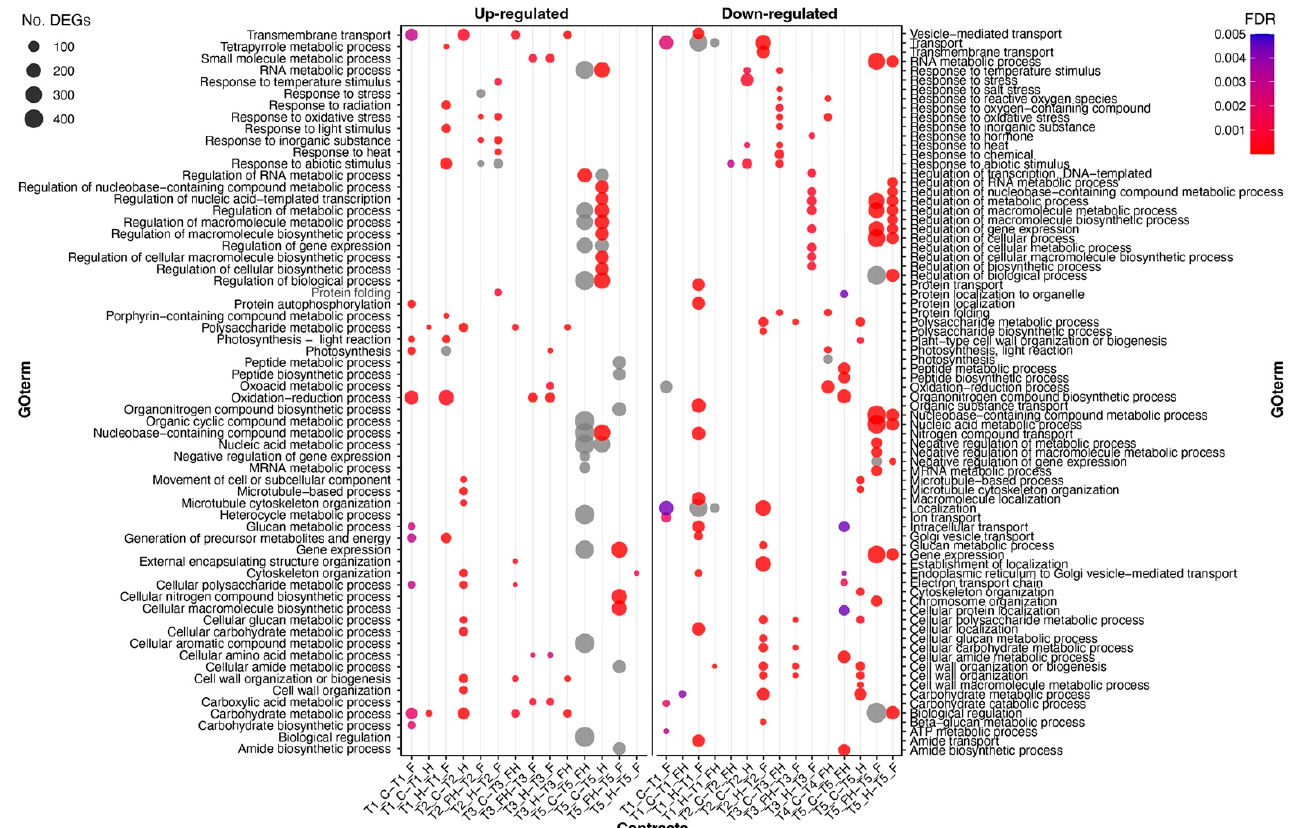
Figure 6. Dot plot of the enriched GO terms in the different contrasts. For each GO term enriched in either up ‐ regulated ( left ) or down ‐ regulated genes ( right ), the number of DEGs annotated, and the FDR statistics are represented as shown in the legends at the top left and right, respectively. Samples within each contrast are named according to the timepoint and treatment (C, control; F, flooded; H, heatwave; FH, flooded plus heatwave).